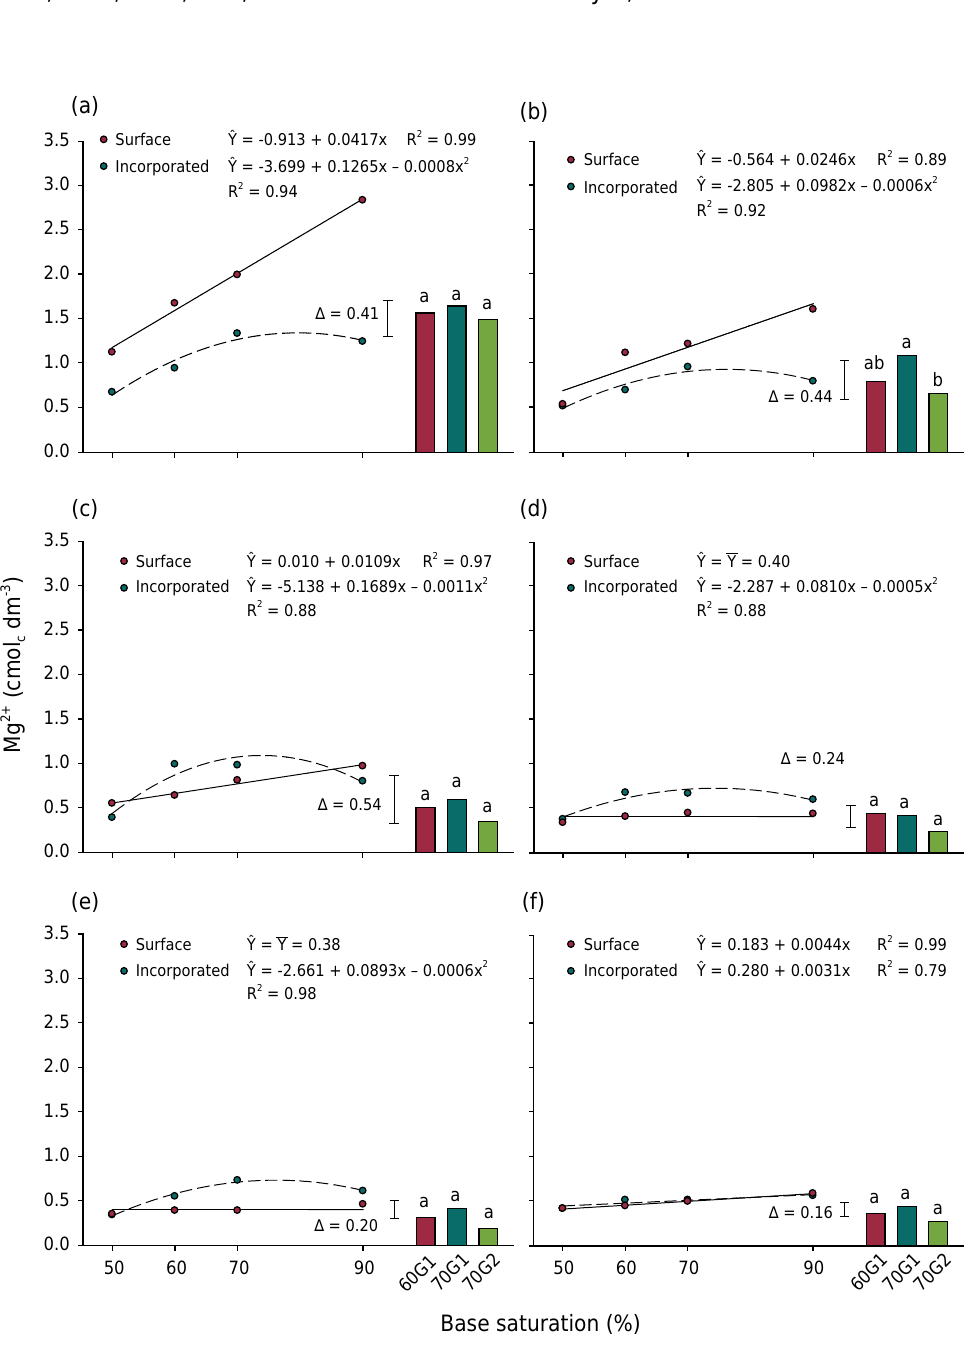
Figure 5. Soil magnesium (Mg 2+ ) content in the 0.00-0.05 (a), 0.05-0.10 (b), 0.10-0.20 (c), 0.20-0.30 (d), 0.30-0.40 (e), and 0.40-0.60 m (f) layers 48 months after treatment. Soils were limed to different base saturation (BS) levels (50, 60, 70, and 90 %) by surface application (SL) or lime incorporation (IL) or treated by surface application of lime (60 and 70 % BS) and a standard (G1) or double (G2) dose of phosphogypsum as 60G1, 70G1, and 70G2. Different letters above columns indicate significant differences between phosphogypsum treatments (Tukey’s test, p<0.05). Vertical bars represent least significant differences between treatments (Dunnett’s test,